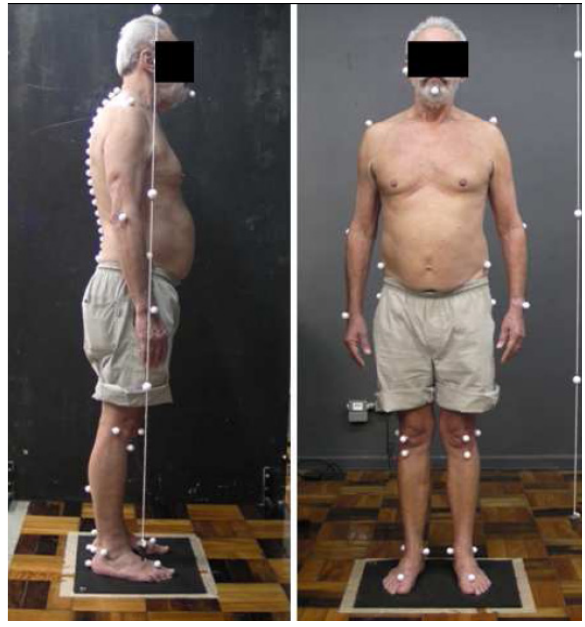
Figure 1 - Evaluation of the postural alignment using